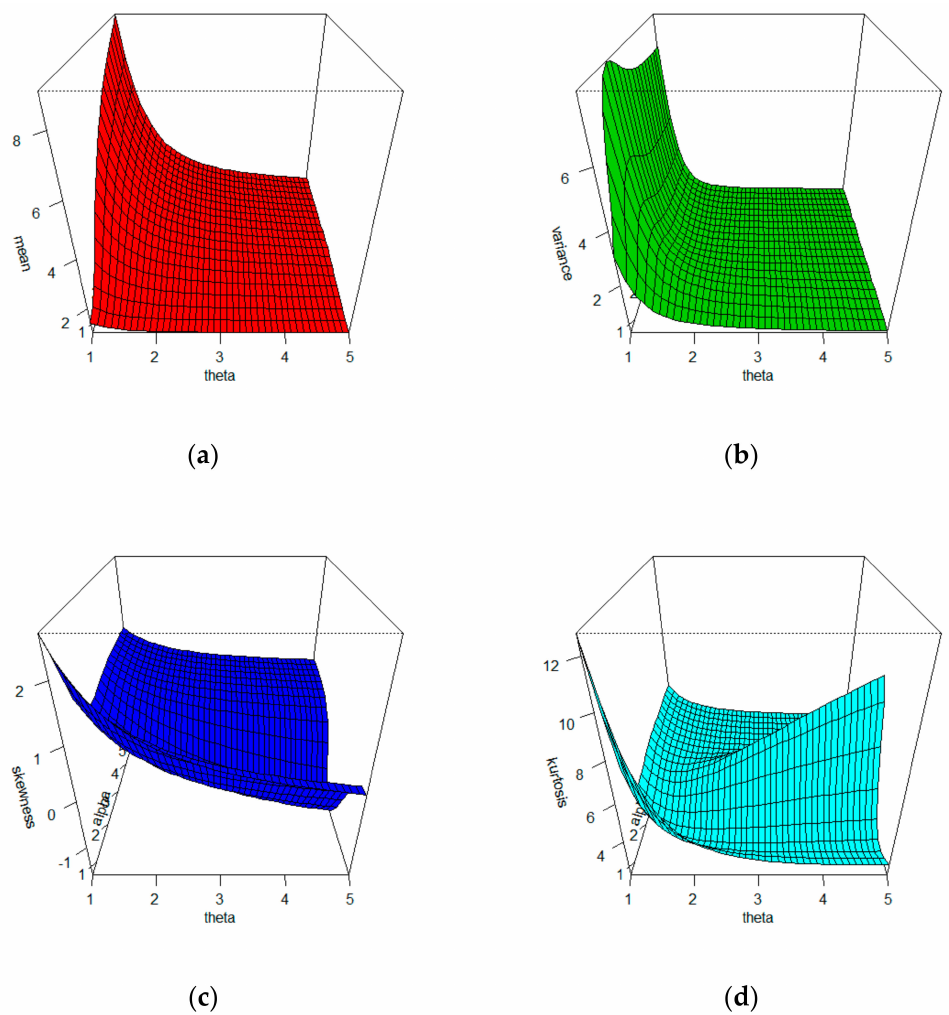
Figure 4. Different plots of ( a ) mean, ( b ) variance, ( c ) skewness, and ( d ) kurtosis of the NMEPA- Wei